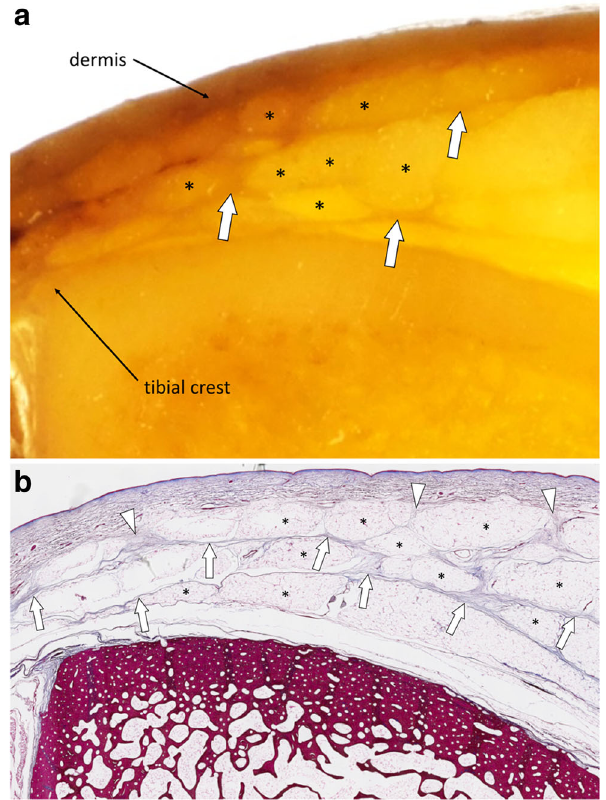
Fig. 4 a Close-up photograph and ( b ) photograph of the corresponding microscopic image (Masson ’ s trichrome stain) of the subcutaneous tis- sues of the lateral part of the leg (yellow square in Fig. 1). The fascia superficialis (white arrows) and the deep peripheral fascia (arrowheads) converge to become macroscopically undistinguishable and microscopi- cally contiguous (black arrows). Superficial nerves (N), arteries (A) and veins (V) run between the fasciae